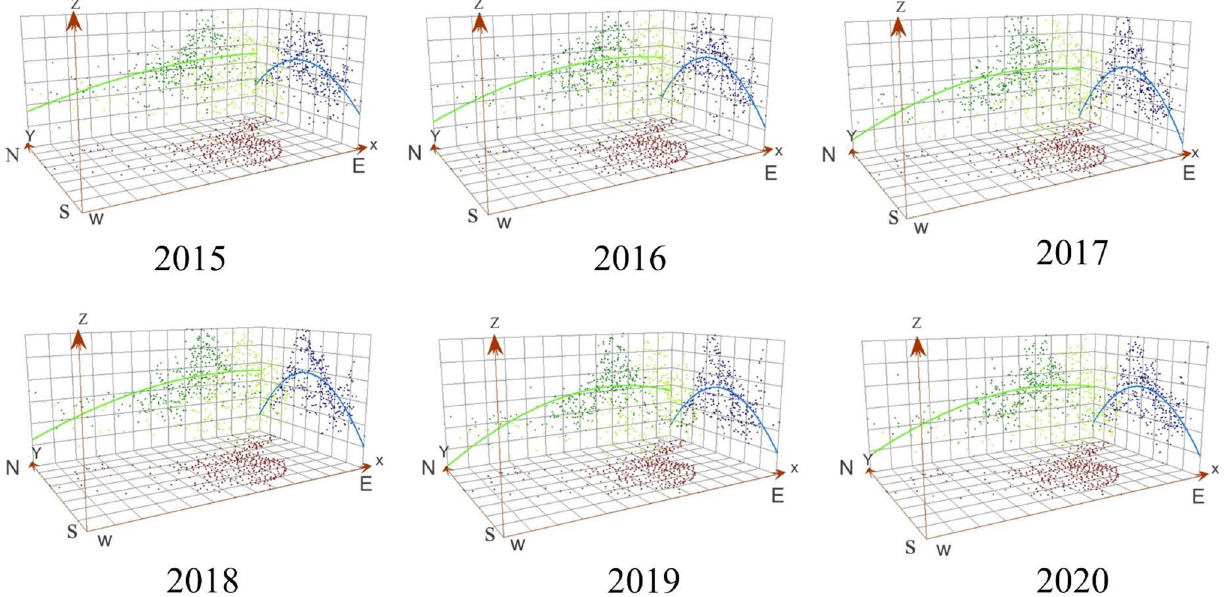
Figure 2. Trend surface analysis of the urban O 3 concentration (the 90th percentile of MDA8) in mainland China from 2015 to 2020.